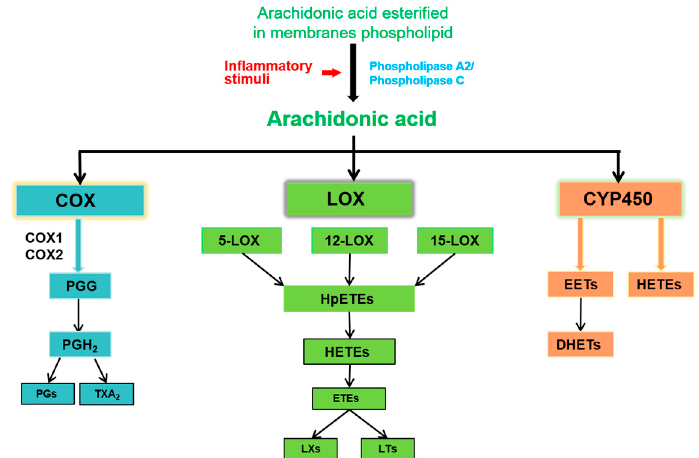
Figure 1. Scheme of eicosanoids biosynthesis pathways from arachidonic acid.